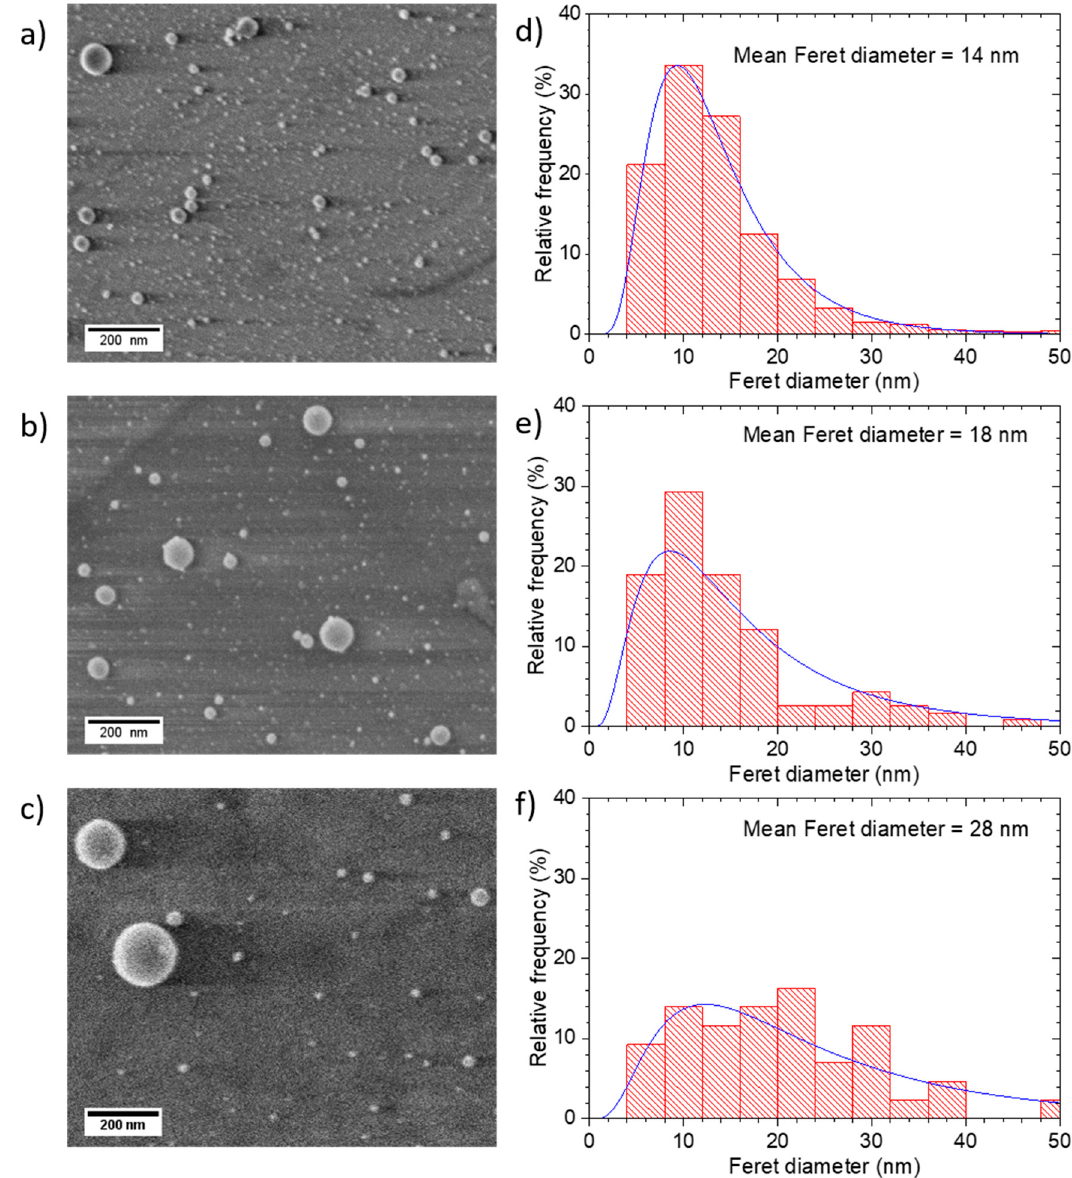
Figure 4. SEM images of 1 × 1.2 µ m 2 area of the Au nanoparticle films deposited at substrate distances of ( a ) 0.5, ( b ) 1 and ( c ) 2 mm, together with the corresponding Feret diameter distributions, ( d – f ) respectively.